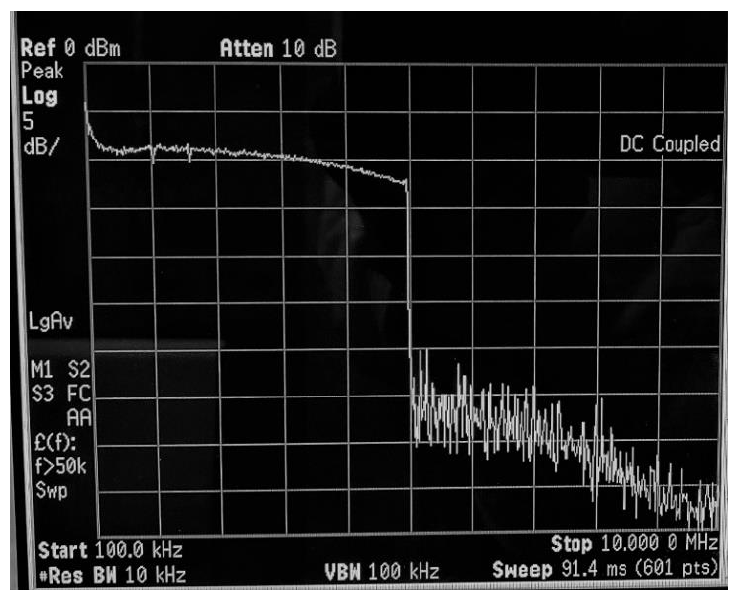
Figure 13. Channel response on a spectrum analyser.